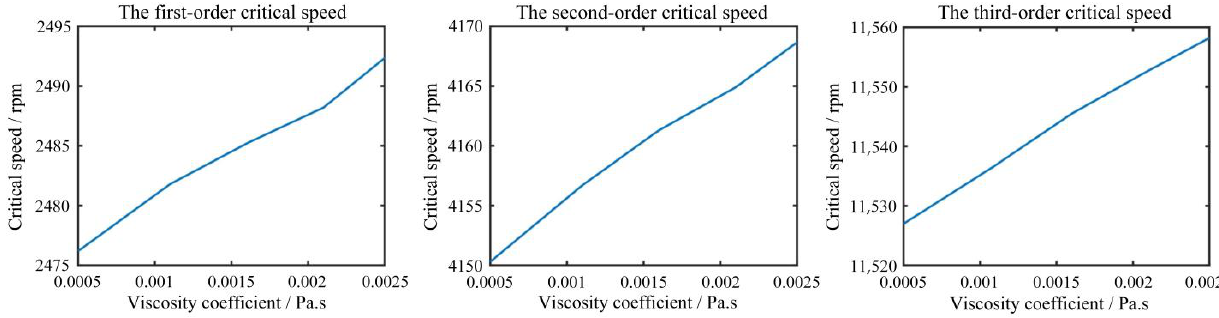
Figure 14. Influences of the viscosity coefficient η on the first three critical speeds.